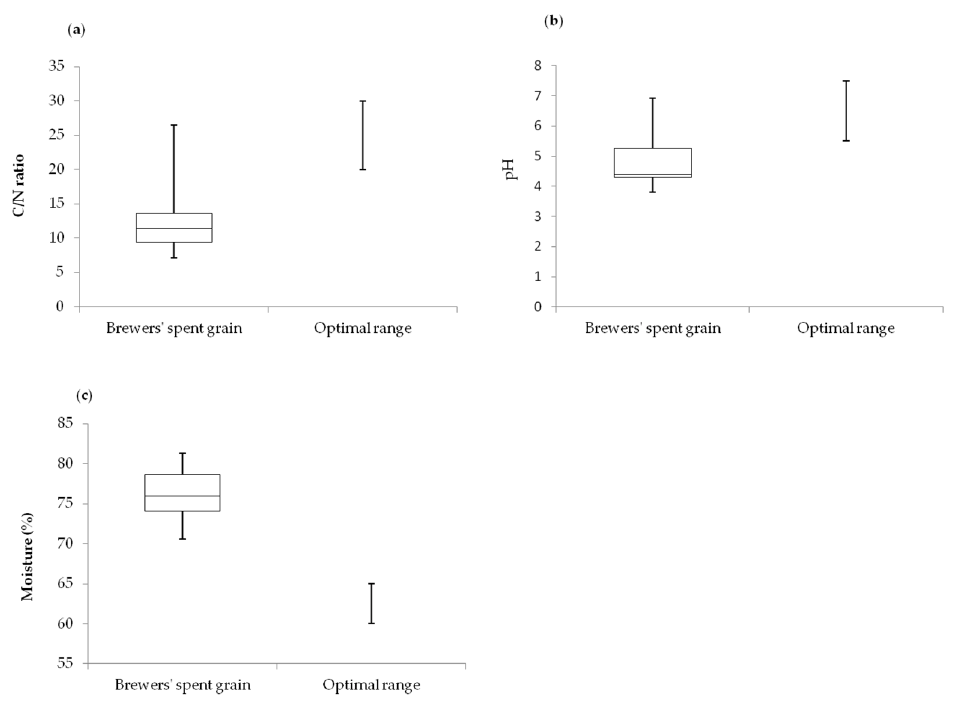
Figure 3. Brewers’ spent grain compositions and optimal composting ranges for C/N ratio ( a ), pH ( b ), and moisture content ( c ). Whiskers indicate minimum and maximum levels, and horizontal bar in the box indicates the median.